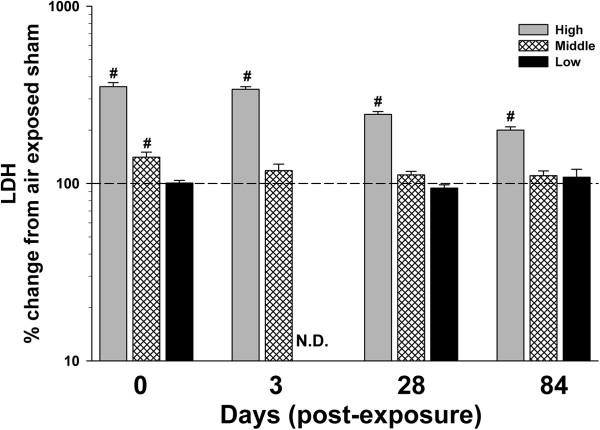
Effect of multi-walled carbon nanotube (MWCNT) inhalation on pulmonary cytotoxicity at different time points after exposure. Lactate dehydrogenase (LDH) activity (U/L), an indication of cytotoxicity, was measured from the first fraction of collected bronchoalveolar lavage fluid. Data are expressed as percent (%) change from respective sham (dashed line – 100%). N.D. – not determined. #p<0.05 vs. other MWCNT depositions for a given time point only.